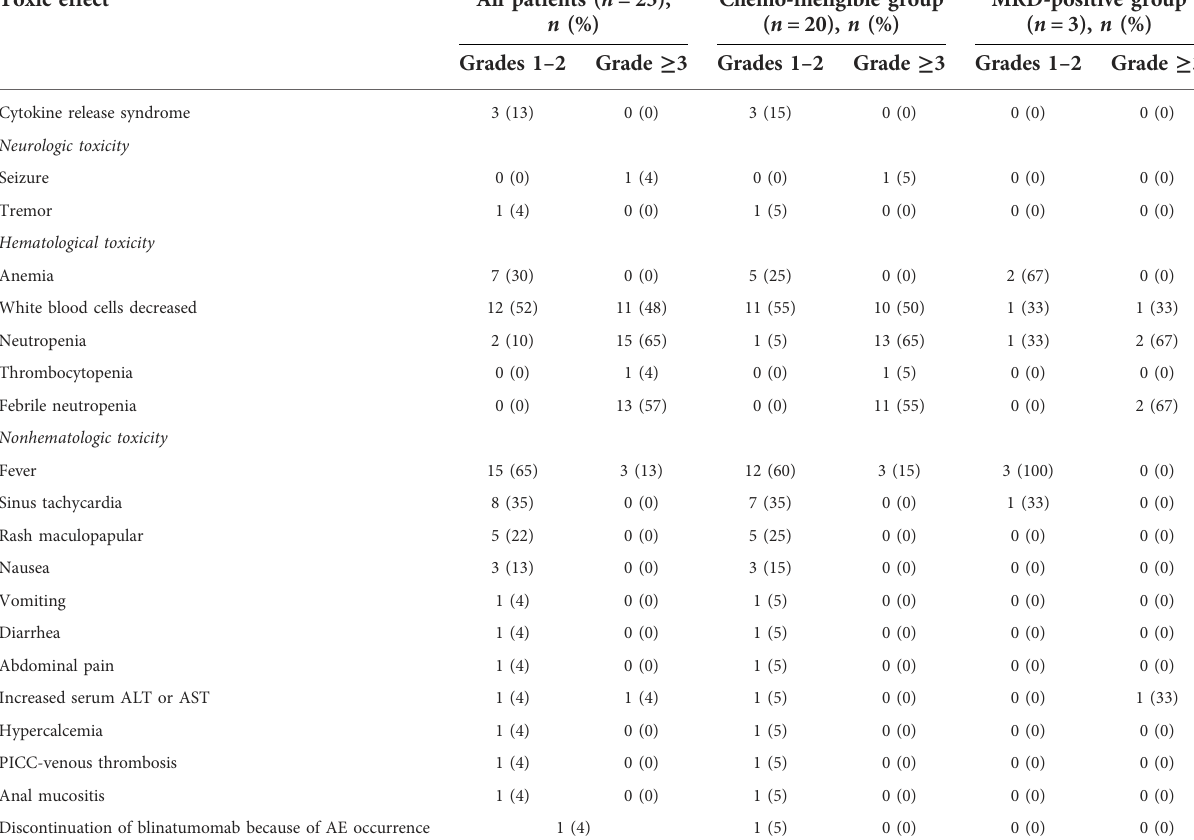
TABLE 3 Adverse events according to CTCAE v